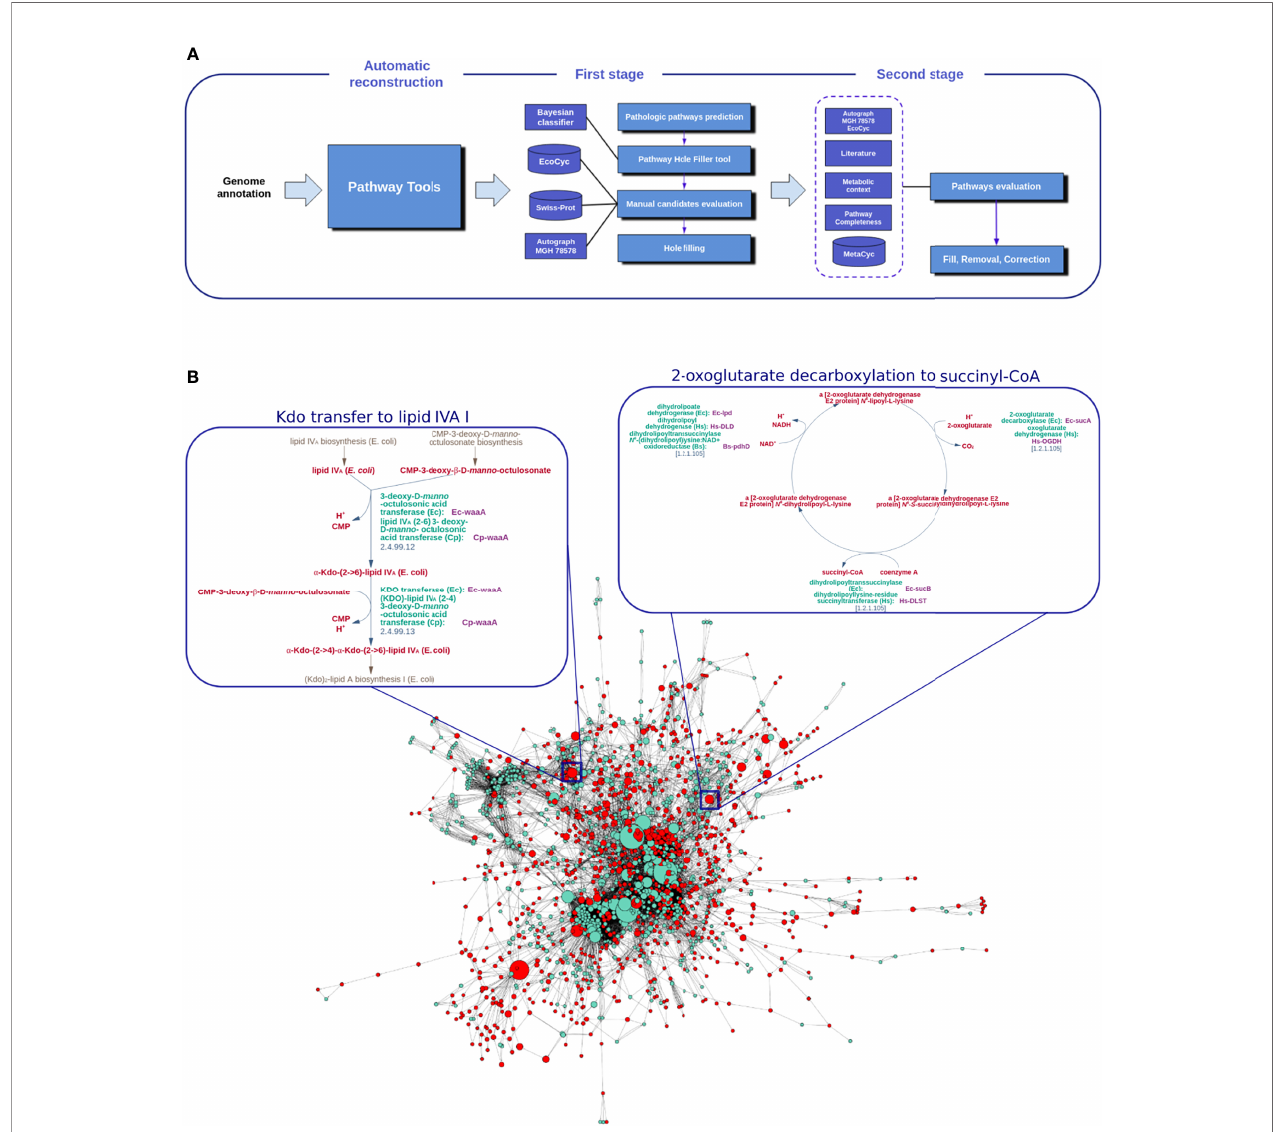
FIGURE 1 | Achieving a manually re fi ned metabolic network for K. pneumoniae Kp13, Kp13-GEM. In (A) the main steps involved in the curation process of Kp13- GEM are shown, initially by an automatic generation of a draft network model using Pathway Tools. This model is subjected to a fi rst annotation stage, where pathway holes and candidates are manually evaluated using the Pathway Hole Filler algorithm, followed by a second stage of curation where all pathways are evaluated. Panel (B) shows Kp13-GEM represented as a reaction graph. Nodes represent reactions, which are linked if a product in a given reaction is used by another as a substrate. The size of the nodes is proportional to their betweenness centrality. The red nodes are choke-points. The metabolic routes for Kdo transfer to lipid IV A and 2-oxoglutarate decarboxylation to succinyl-CoA, top ranked pathways in and, respectively, are detailed in the boxes next to the reaction